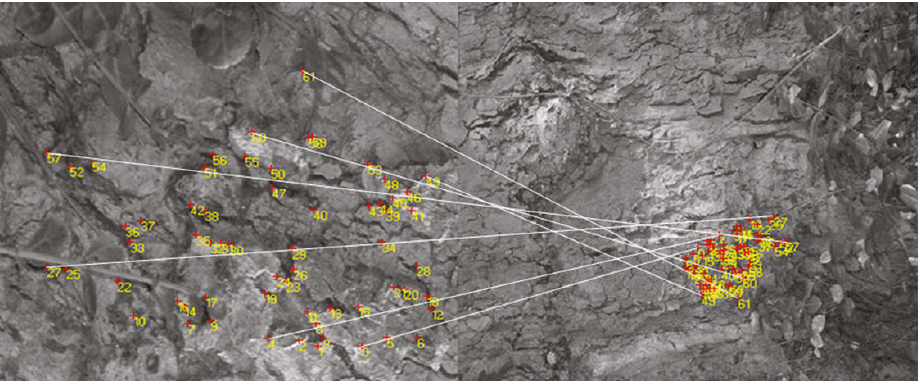
Figure 12: Matching result for image pair Bark (frames 1 and 6 of “Bark” sequence). The scale factor is 4.0, and the rotation angle is 154